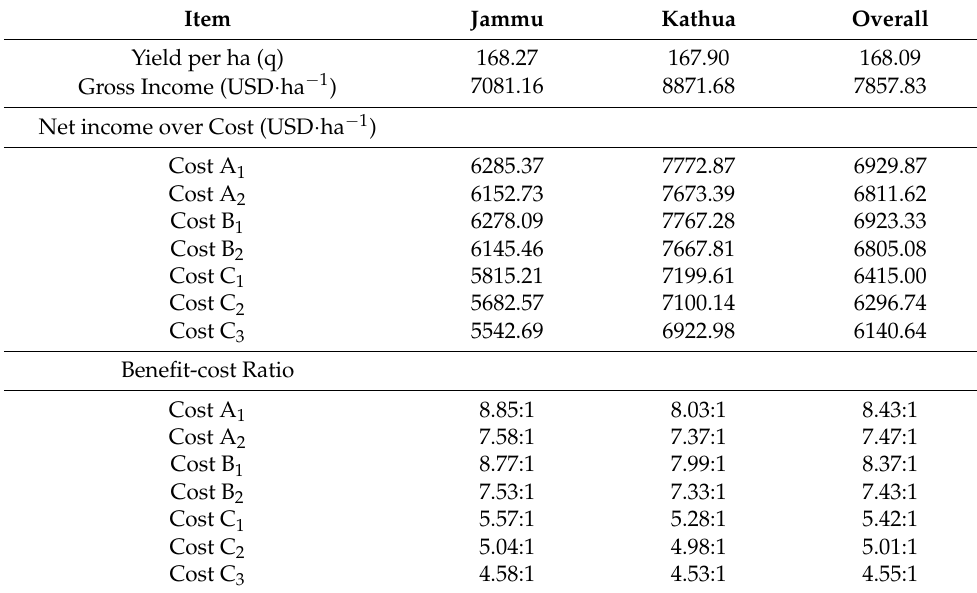
Table 3. Productivity, income and cost concept-wise economics of marigold